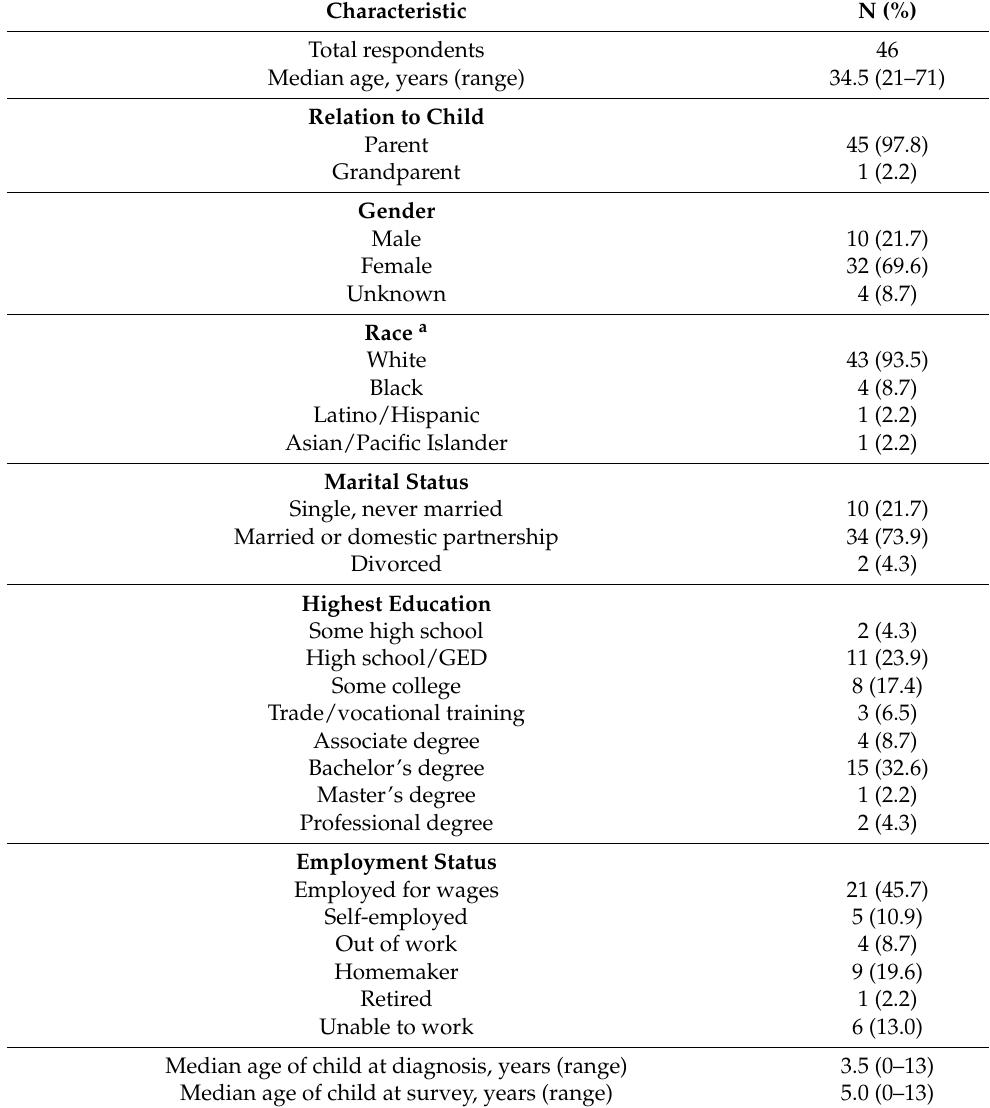
Table 1. Demographic information for caregivers completing the survey